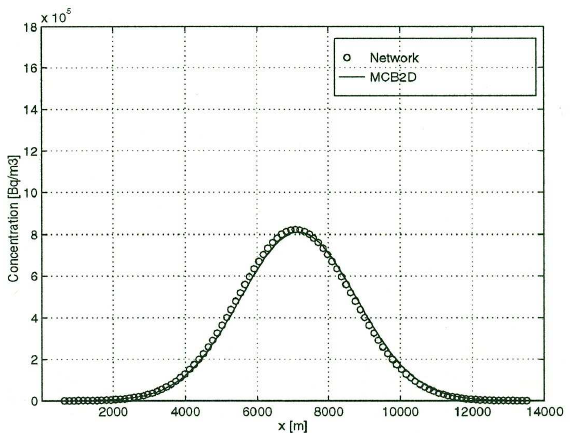
Fig. 4.8. Network 4, v/R=1.9 (cid:215) 10 -3 m/d, e test=1.51%